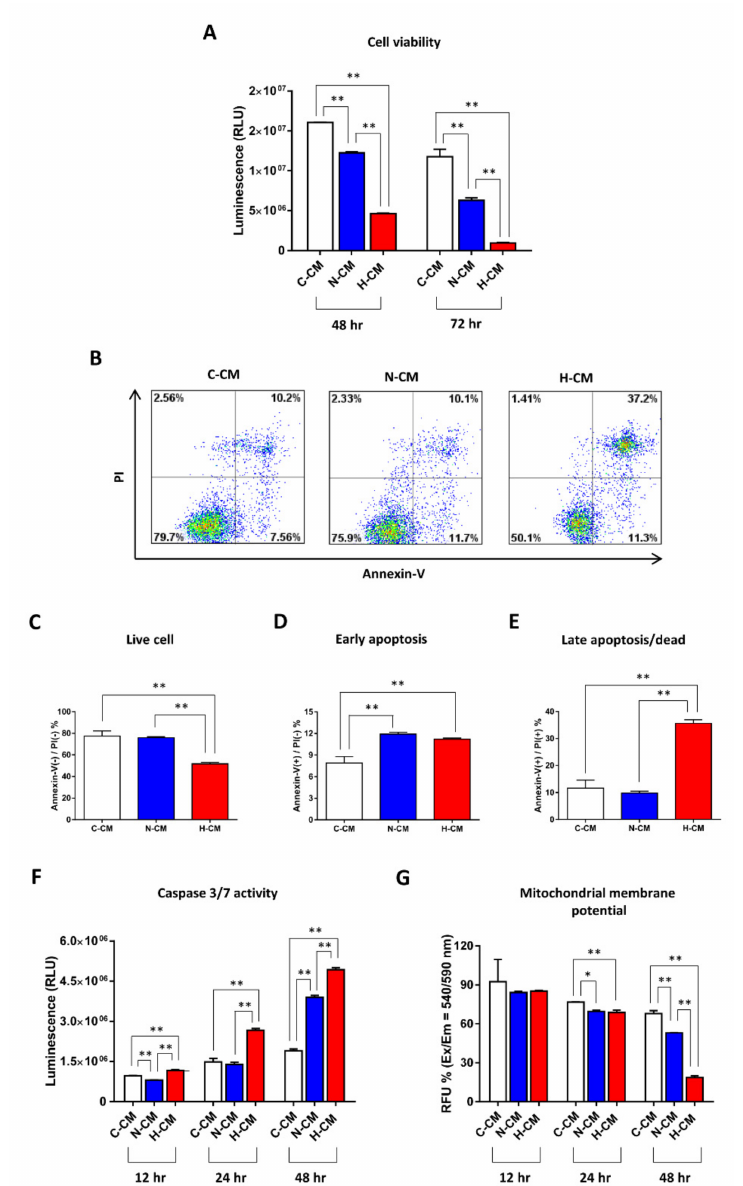
Figure 1. H-CM decreased the viability and increased the apoptosis of HeLa cells. The viability of HeLa cells treated with C-CM, N-CM, or H-CM ( A ). The viability of HeLa cells was measured using the CellTiter-Glo assay after 48 and 72 h of treatment with C-CM, N-CM, or H-CM. The proportion of live cells [Annexin ( − )/PI( − )] ( B , C ), early apoptotic cells [Annexin (+)/PI( − )] ( B , D ), and late apoptotic cells [Annexin (+)/PI(+)] ( B , E ) among HeLa cells treated with C-CM, N-CM, or H-CM. Cells were evaluated using the Annexin/PI staining assay and flow cytometry after 48 h of treatment with C-CM, N-CM, or H-CM. Caspase-3/7 activity in HeLa cells treated with C-CM, N-CM, or H-CM ( F ). Caspase-3/7 activity in HeLa cells was measured using the Caspase-Glo 3/7 Assay after treatment with C-CM, N-CM, or H-CM for 12 h to 48 h. The MMP activity in HeLa cells treated with C-CM, N-CM, or H-CM ( G ). The MMP activity in HeLa cells was measured using the Orange Mitochondrial Membrane Potential Assay after treatment with C-CM, N-CM, or H-CM for 12 h to 48 h. Data are expressed as the mean ± SD of experiments performed in triplicate (each group n = 3, * p < 0.05, ** p < 0.01, one-way ANOVA). C-CM, serum-free medium as control; N-CM, conditioned medium from normoxic HDFs; H-CM, conditioned medium from hypoxic HDFs. Image ( B ) was produced using FlowJo v10 (Treestar, San Carlos, CA, USA). Images ( A , C – F ) were produced using GraphPad Prism version 7.00 (GraphPad Software, San Diego, CA,